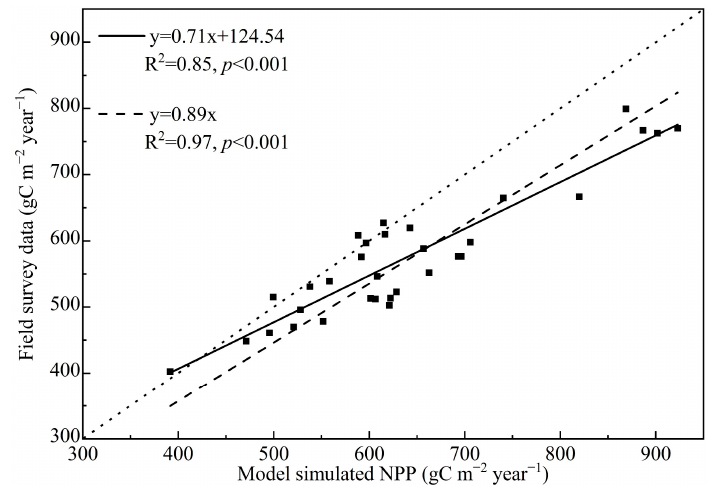
Figure 2. Validation result between model simulated NPP and field survey data. The dot line was the 1:1 line. The solid line was the linear ‐ fitting line, and the dash line was the line of linear ‐ fitting without constant. Details of the survey methods can be found in Section 2.2, while the concurrent model ‐ simulated NPP values are extracted at the same site.